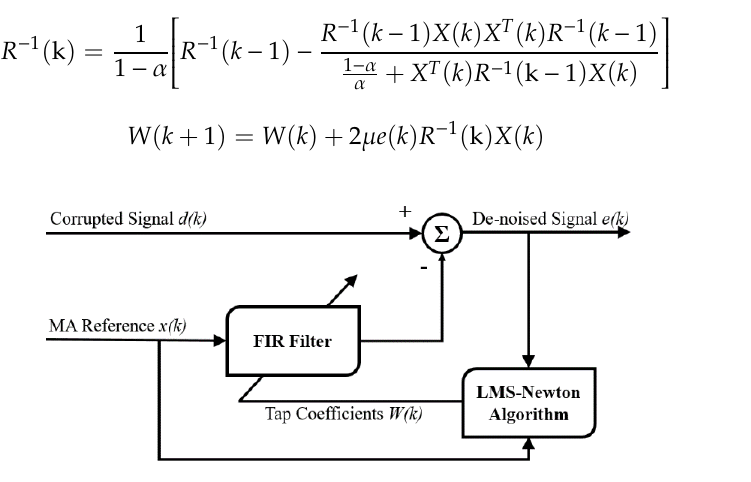
Figure 2. Signal flow of adaptive noise cancellation.